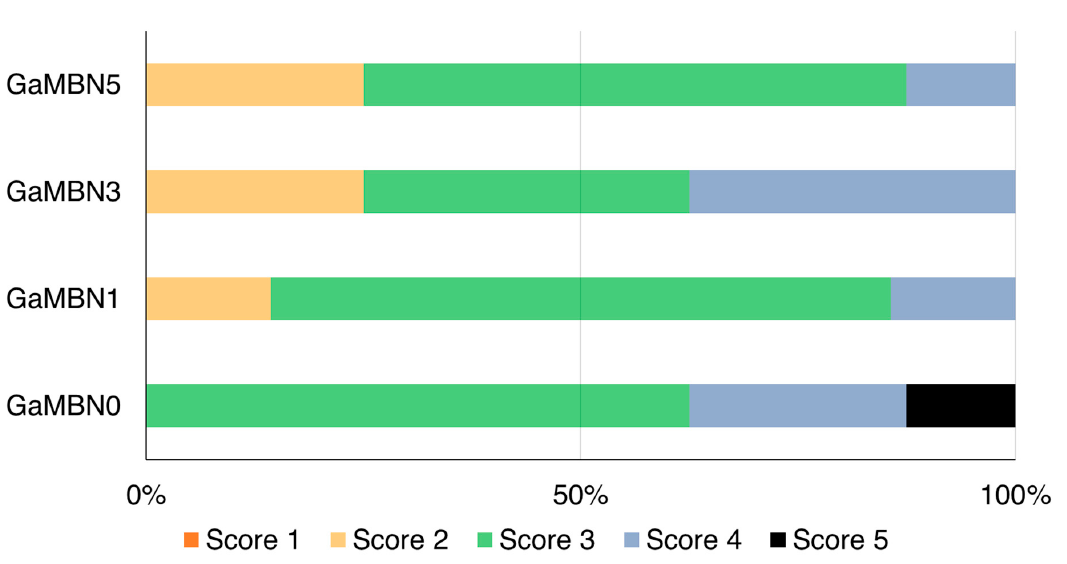
Figure 9. Adhesive remnant index (ARI) scores of four GaMBN resins used as orthodontic bonding adhesives. Based on the Kruskal–Wallis test at α = 0.05, the ARI scores were not significantly different (n = 8).